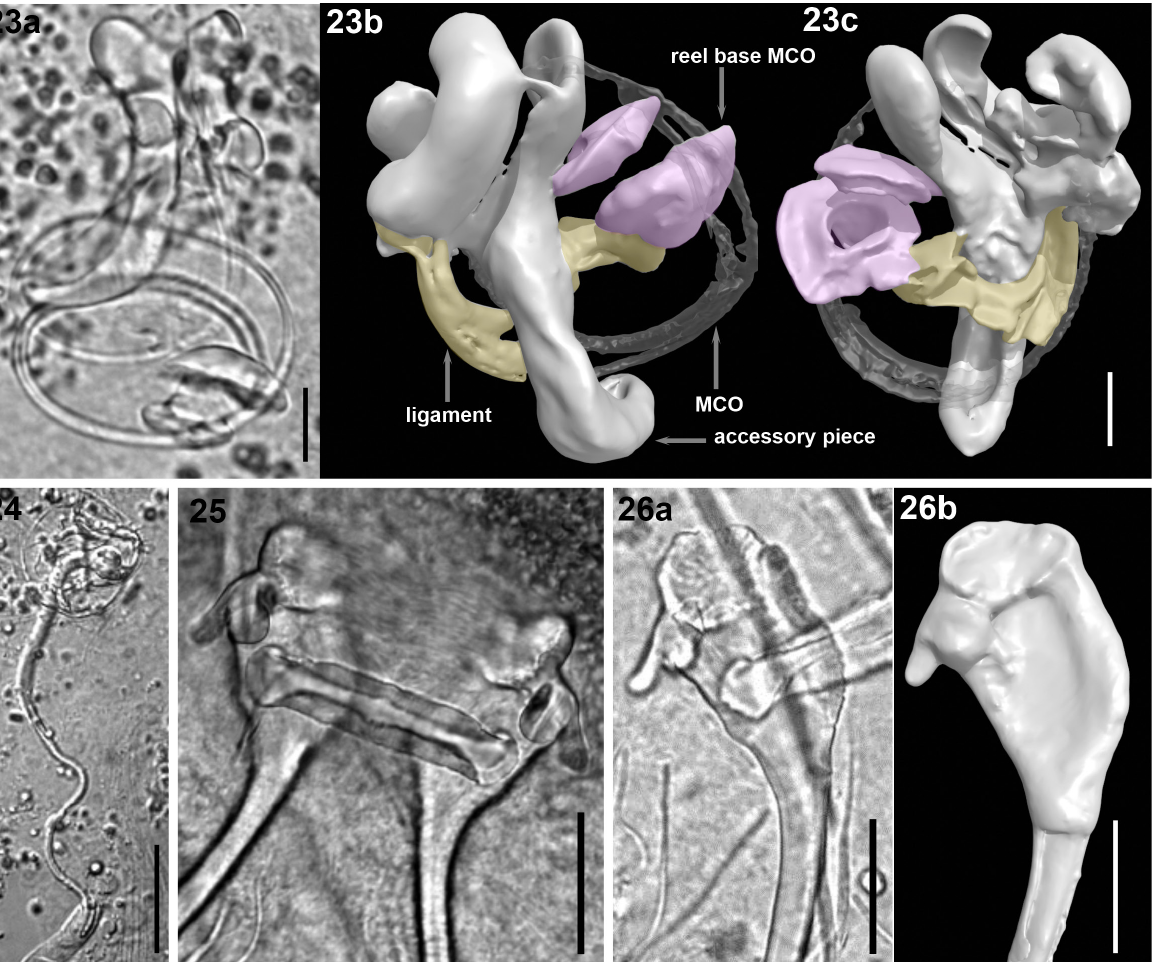
Figures 23 - 26 - Rhinoxenus paranaensis n. sp. 23. Male copulatory complex, 23a . Microscope photograph (ventral view), 23b. 3D-reconstruction (ventral view), 23c . 3D-reconstruction (dorsal view); 24 . Vagina (ventral view); 25 . Ventral bar; 26a . Base of ventral anchor (microscope photograph, ventral view); 26b . Base of ventral anchor 3D-reconstruction (ventral view). Scale bars: 23-24 = 10 µm; 25-26 = 20